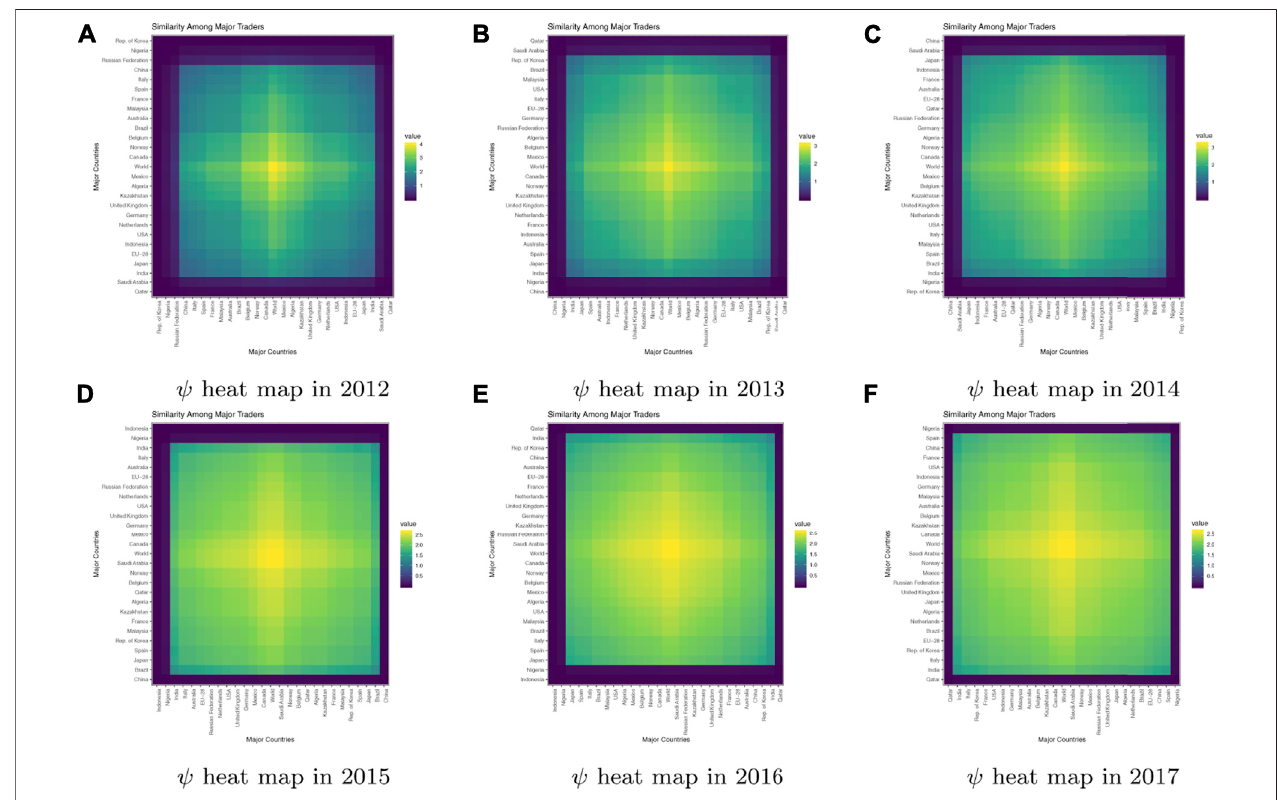
FIGURE 2 | ψ heat map from year 2012 to